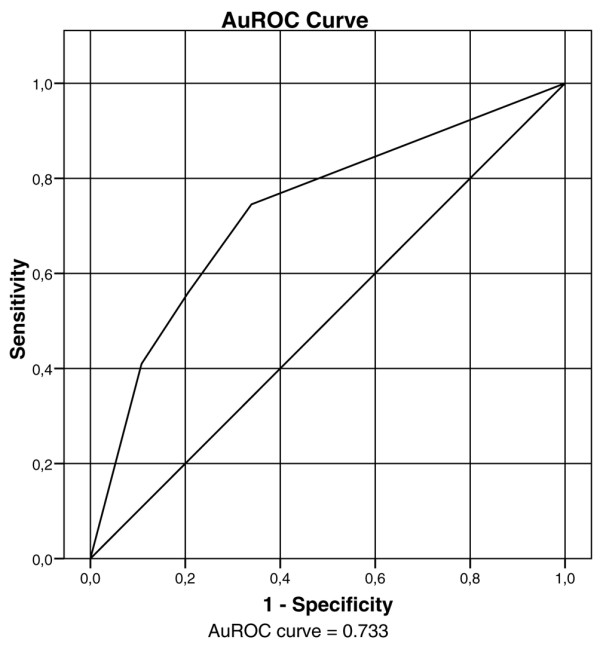
Area under the receiver operator characteristic (AuROC) curve for inhospital mortality for the Risk, Injury, Failure, Loss of Kidney Function, End-stage Kidney Disease criteria (P < 0.0001).